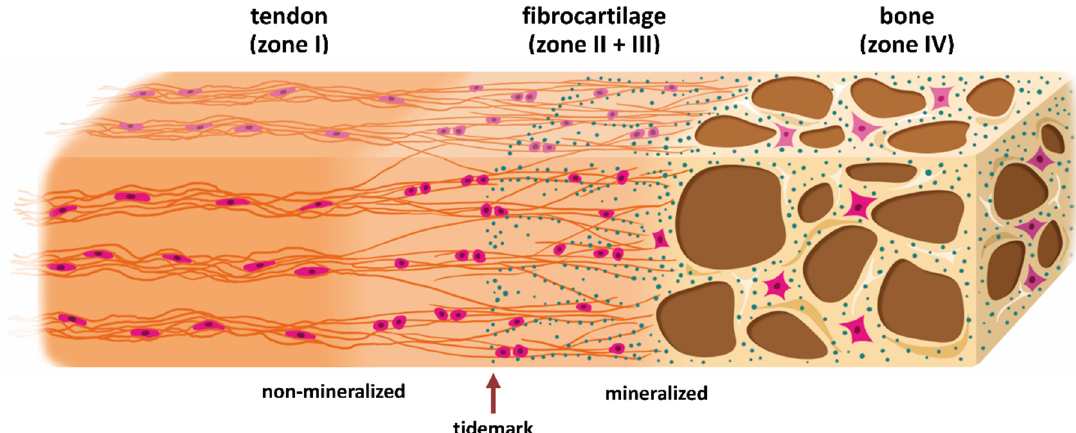
Figure 1. Schematic representation of a direct enthesis with four interwoven zones. Histologically, the basic scaffold is based on a largely oriented fiber course of collagens and a corresponding orientation of the cell axes in the tendon zone (I), while cartilage and bone zones have less or no such orientation of the fibers. Major differences in the composition result from different cell types, molecules of the extracellular matrix and mineral content. The tendon zone contains elongated, fibroblast ‐ like cells, called tenocytes, embedded in an extracellular matrix of predominantly collagen type I, proteoglycans such as aggrecan and fibromodulin as well as glycoproteins like lubricin, elastin and tenascin C [7]. The fibrous cartilage zone II contains rounded chondrocytes in an extracellular matrix which transitions from collagen type I to collagen type II and collagen type III, together with aggrecan as a major non ‐ collagenous protein. Collagen type II is also found in the mineralized fibrous cartilage zone (III), forming a mesh which anchors tendons to bone [7]. The transition between zone II and III, from non ‐ mineralized to mineralized fibrocartilage, is marked by dense calcification, which is called tidemark. In addition, mineralization based on calcium phosphate begins (small turquoise ‐ colored dots). The mineralization is pronounced in the bone zone (zone IV) and contains also crystals (larger turquoise ‐ colored dots). Individual collagen type I fibers are not shown here. Osteoblasts, osteocytes and osteoclasts are the major cell types within bone. The highly vascularized bone provides nutrients and, if applicable, cells to the avascular enthesis [12]. This highly specialized structure – about 0.5 mm in length [15] – results in different mechanical properties which guarantee the enormous stability and thus the functionality of such a transition in vivo. 1.2. Development of the Enthesis The formation of the enthesis begins during the fetal development and continues even postnatally [18]. Chondrocytes of the cartilage start to proliferate and synthesize extracellular matrix until they reach hypertrophy. Thereupon, the cartilage is mineralized by endochondral ossification and collagen fibers and minerals are remodeled by fibrocartilaginous transition. An infiltration of vascular tissue into the mineralized fibrocartilage, which brings bone precursor cells into the enthesis, allows these cells to remodel parts of the mineralized matrix into bone [19,20]. During embryonic development of bones two types of progenitors are involved. Progenitors of the primary cartilage template only express sex ‐ determining region Y ‐ box 9 (SOX9). Another progenitor population is influenced by the opposing expression of gradients of SOX9 and scleraxis (SCX) [21,22]. These progenitors are added to the primary cartilaginous template and form bone eminences which act as anchoring points for tendons in the attachment unit [23]. As it is also expressed in progenitors of primary cartilage, the transcription factor SOX9 is a key molecule in chondrocyte differentiation and continuously active during early and advanced chondrogenesis. SCX is also a transcription factor and pivotally regulates differentiation of tendinous tissues. Knockout experiments revealed that loss of SCX expression results in drastic developmental disorders in the enthesis like changes in cell morphology, fiber organization and enthesis size [21]. As development and differentiation into tenocytes and chondrocytes progresses, the pool of SOX9 and SCX ‐ expressing progenitors gradually decreases.